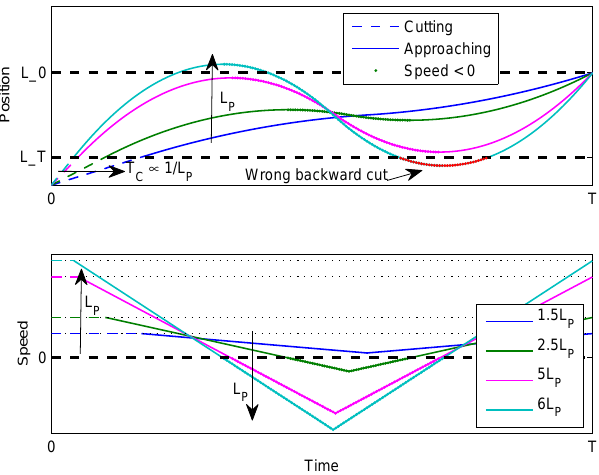
Figure 7. Backward cut increasing the product